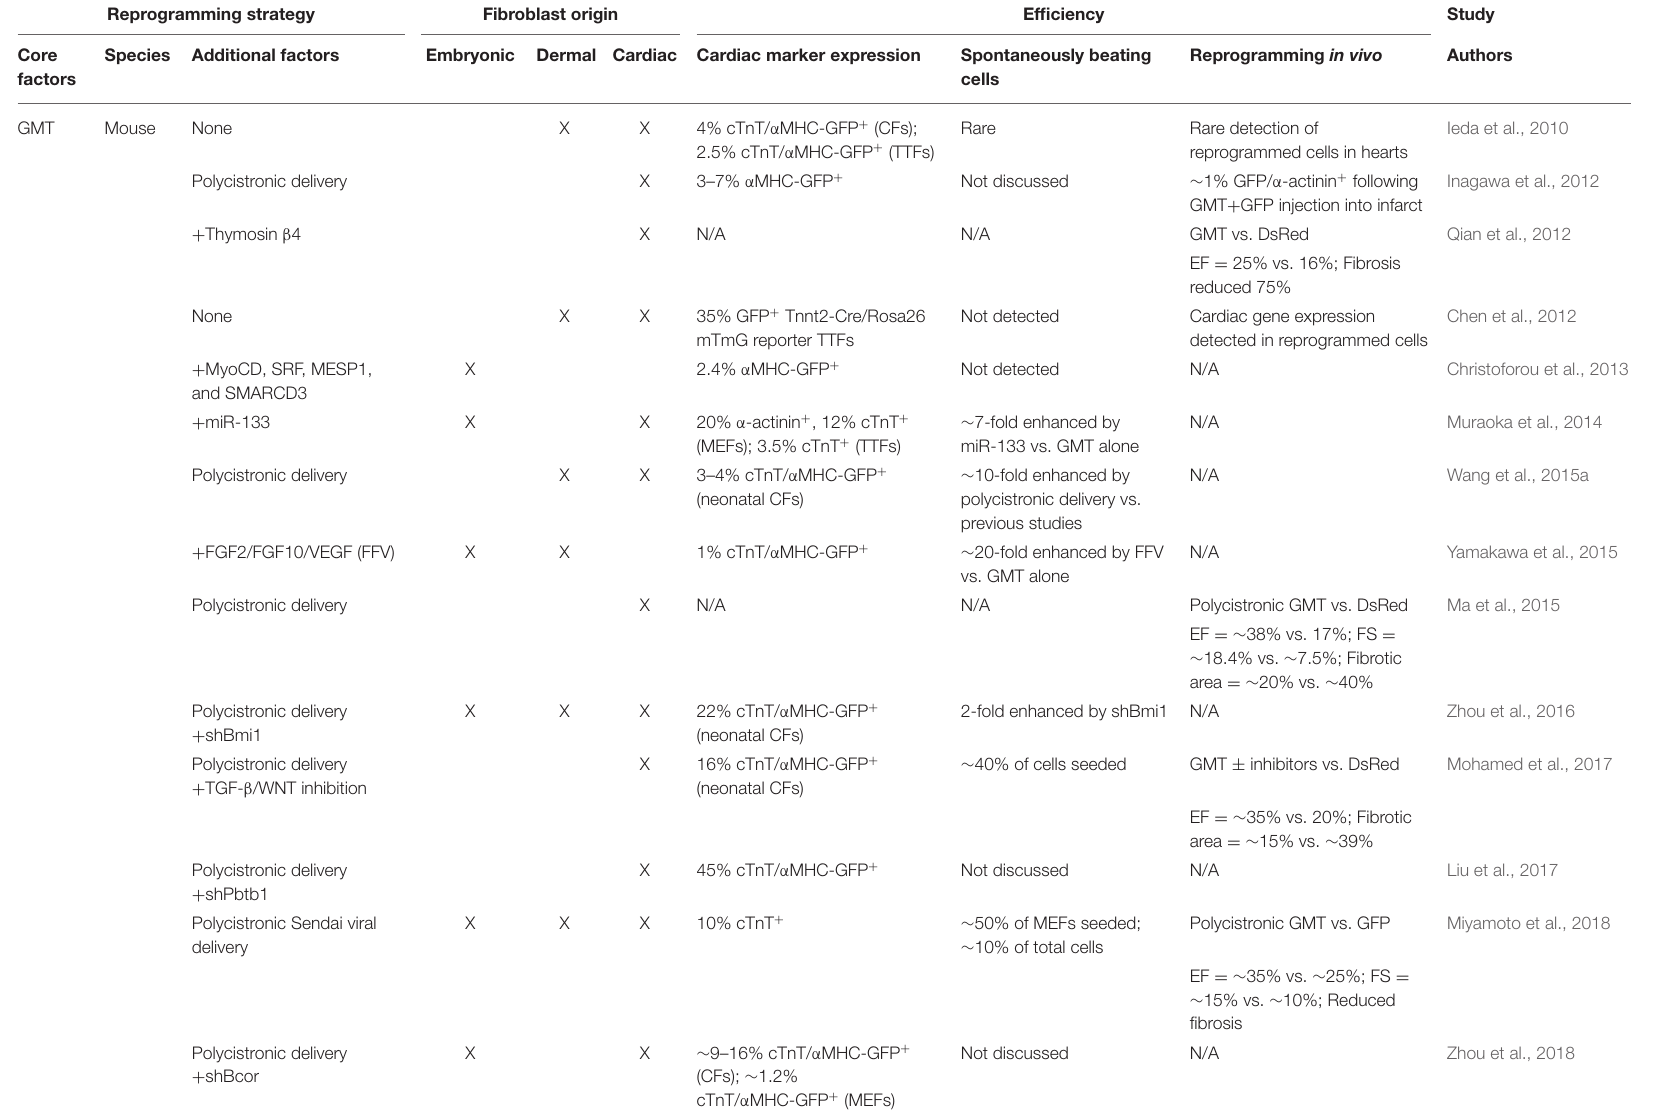
TABLE 1 | In vitro and in vivo efficiencies of GMT-based reprogramming